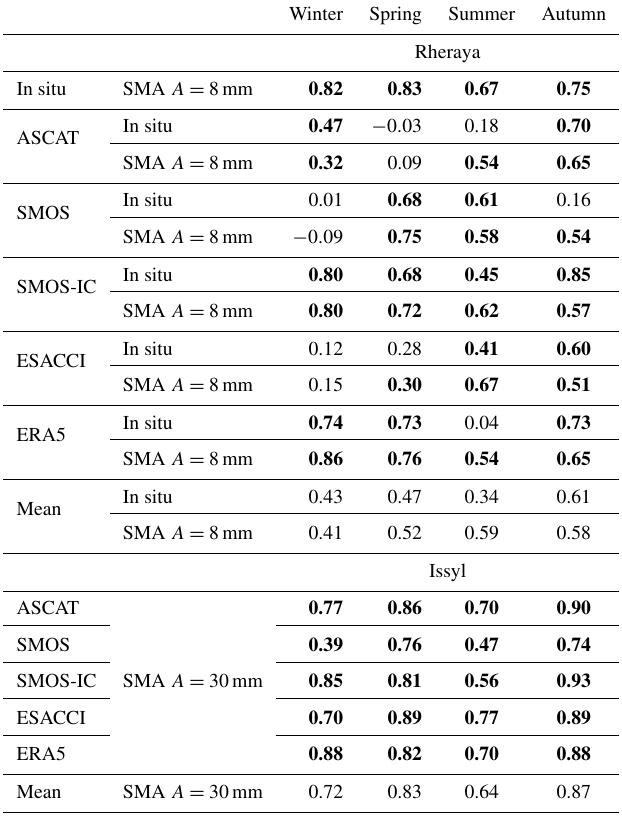
Table 5. Seasonal correlation between the different soil moisture data, in situ measurements and the SMA model (significant correla- tions are represented in